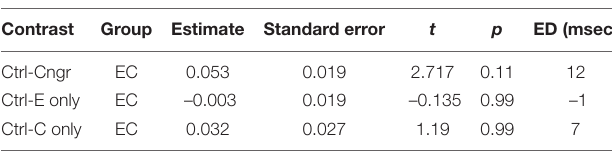
TABLE 10 | Results of post hoc , within-group tests of RTs for congruent, English-only, and Chinese-only items relative to the control items for English–Chinese